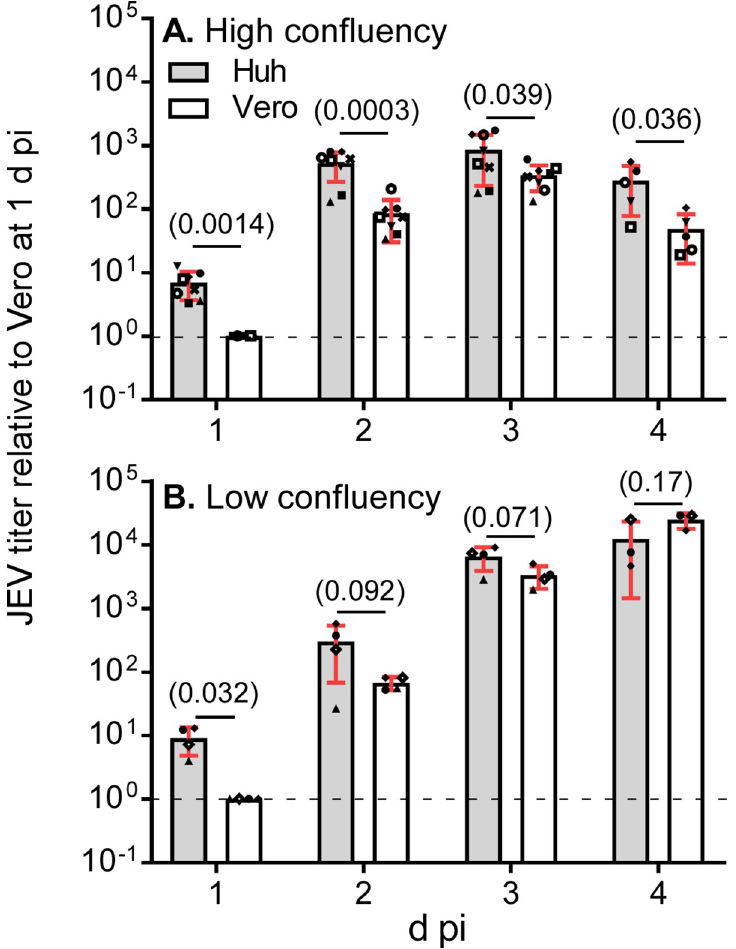
Fig 2. JEV titer of Huh7.5.1–8 cells was higher than that of Vero cells early in infection. (A, B) Cells were seeded at 1 x 10 5 (A; high confluency conditions) or 2 x 10 4 (B; low confluency conditions) cells per well of a 24-well plate one day before infection and then infected with JEV at MOI 0.1. Culture supernatants were harvested at 1 − 4 d pi, and virus titers in the supernatants were determined by plaque assay. Each symbol represents the relative titer value calculated by dividing each titer value in PFU/well by that of Vero cells at 1 d pi in the same experiment. Bars with error bars represent the mean ± SD of the relative values from multiple independent experiments. Because the 4 d pi time point was omitted in several experiments, numbers of experiments differ at 1 − 3 d pi and at 4 d pi: A, n = 8 [1 − 3 d pi] or 5 [4 d pi]; B, n = 5 [1 − 3 d pi] or 3 [4 d pi]. Statistical significance was determined by a one-sample t test (1 d pi) or unpaired two-tailed t test (2 − 4 d pi). Values in parentheses indicate p values, and those less than 0.05 were considered statistically significant. Actual titers in PFU/well for Vero cells at 1 d pi were (8.75 − 24.6) × 10 4 (A) and (2.73 − 10.2) × 10 3 (B). Huh, Huh7.5.1–8